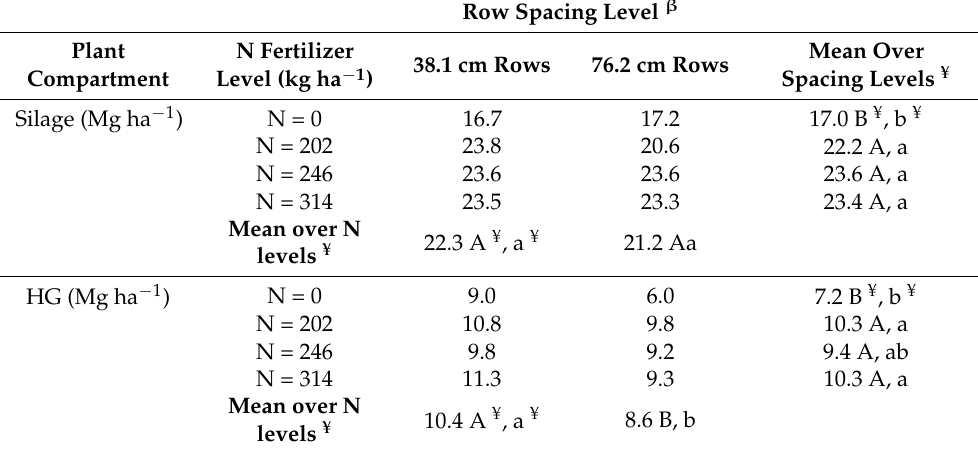
Table 2. Differences in total biomass silage and harvested grain (HG) mean dry weight yields (Mg ha − 1 ) of corn grown in the small plots (study 1) during 2018 under different row spacing systems and nitrogen rates ¶